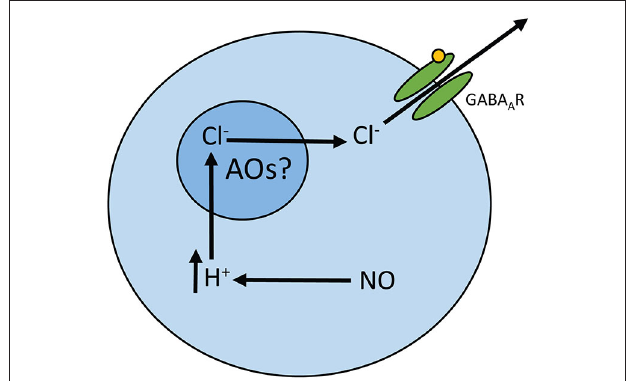
FIGURE 1 | Model for NO-dependent release of internal Cl − . This model depicts our understanding of the NO-dependent release of Cl − as well as the hypothesis tested in this paper. With NO, a cytosolic acidification occurs that is required for internal Cl − release. The presence of Cl − in the cytosol can be measured as an inward Cl − current due to Cl − leaving open GABAARs. Here, we test the hypothesis that the NO releasable Cl − originates from acidic organelles